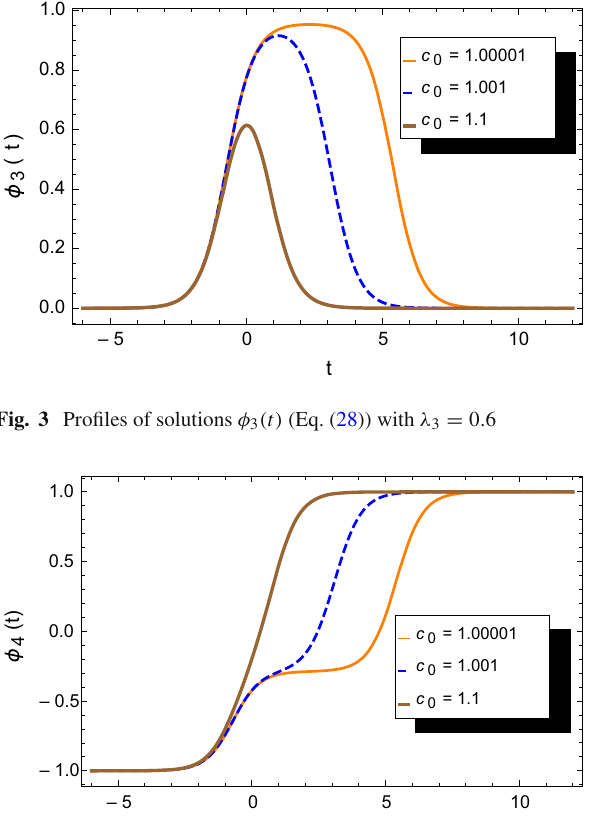
( t ) (Eq. (22)) with μ = 1 4